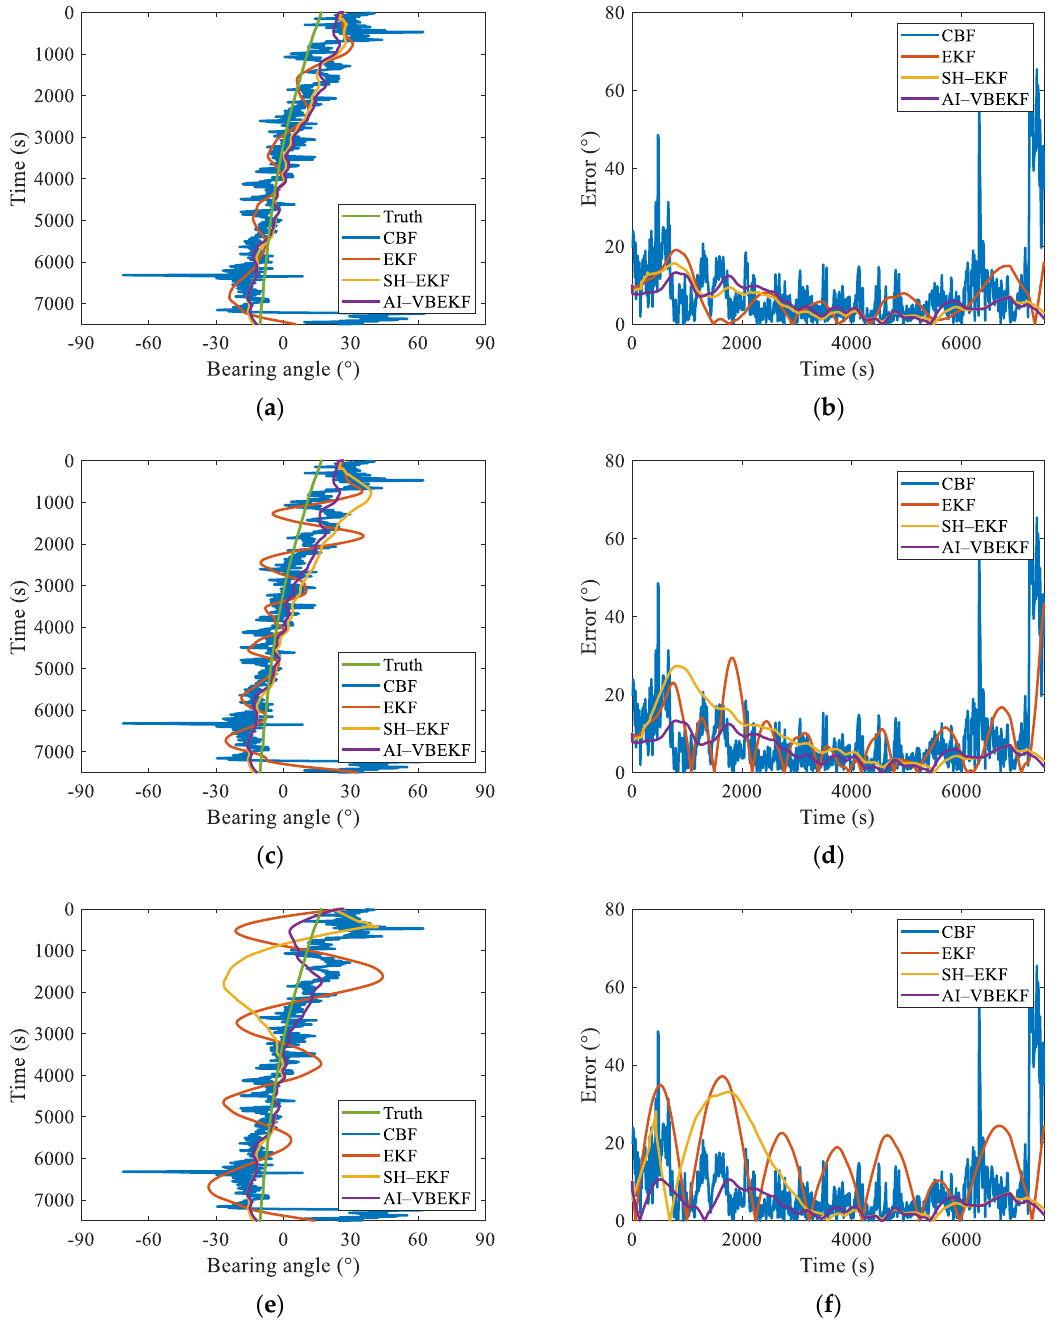
Figure 7. Experimental results of CBF-based DOA estimation, EKF, SH-EKF and AI-VBEKF on raw data. ( a ) Trajectories obtained using the raw data under P 0 = diag 25,10 − 5 ] , ( b ) BEEs obtained using the raw data under P 0 = diag 25,10 − 5 ] , ( c ) trajectories obtained using the raw data under P 0 = diag 50,10 − 5 ] , ( d ) BEEs obtained using the raw data under P 0 = diag 50,10 − 5 ] , ( e ) trajectories obtained using the raw data under P 0 = diag 100,10 − 5 ] , and ( f ) BEEs obtained using the raw data under P 0 = diag 100,10 − 5 ] .